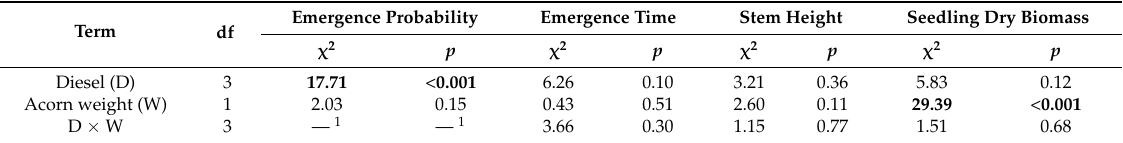
Table 1. Results of mixed effects models for the nursery experiment.